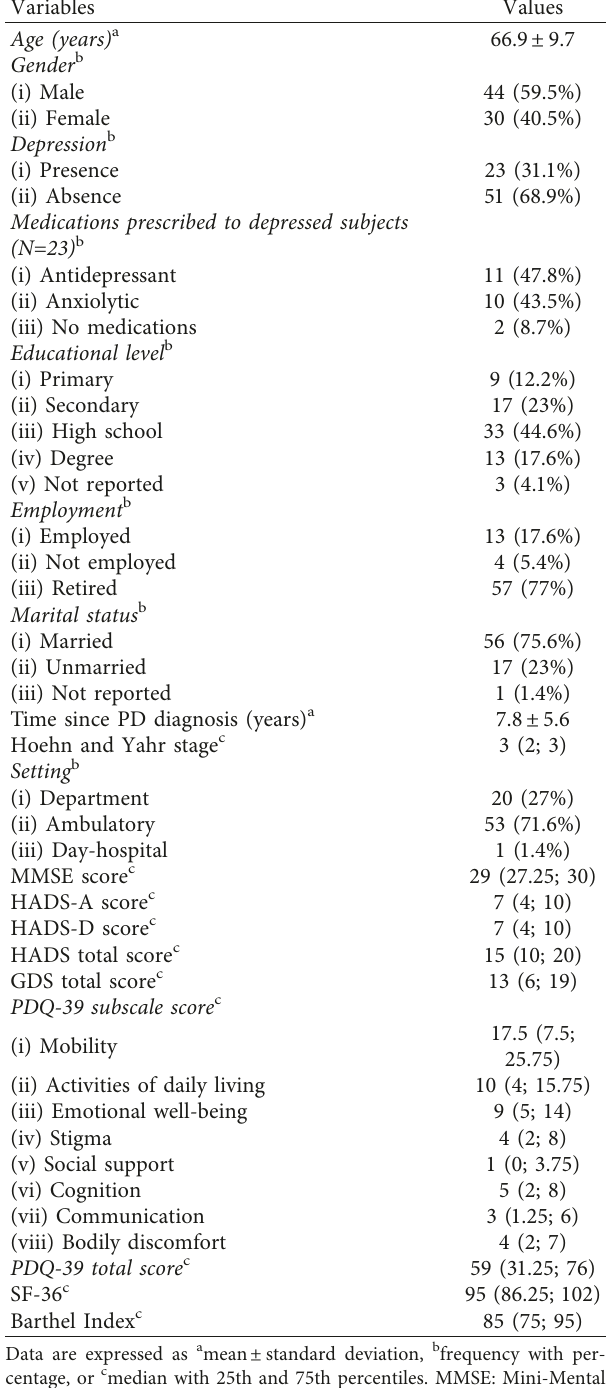
Table 1: Main demographic and clinical characteristics of the sample ( N �